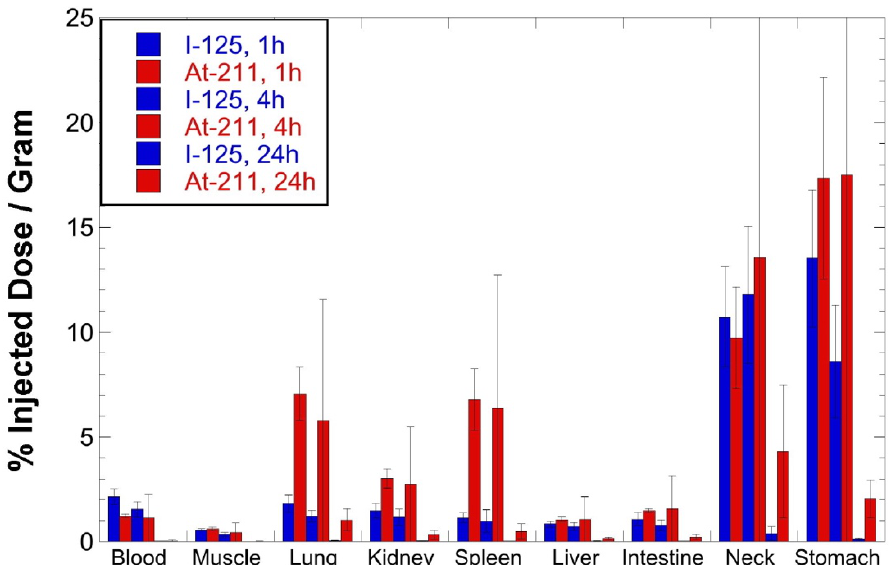
Figure 7. Graph showing concentration as %ID/g of [ 125 I]NaIO 3– and [ 211 At]NaAtO 3– in tissues of athymic mice at 1, 4 and 24 h p.i. (n = 5). See Table S2 in Supplementary Materials for a tabulation of %ID/g data.